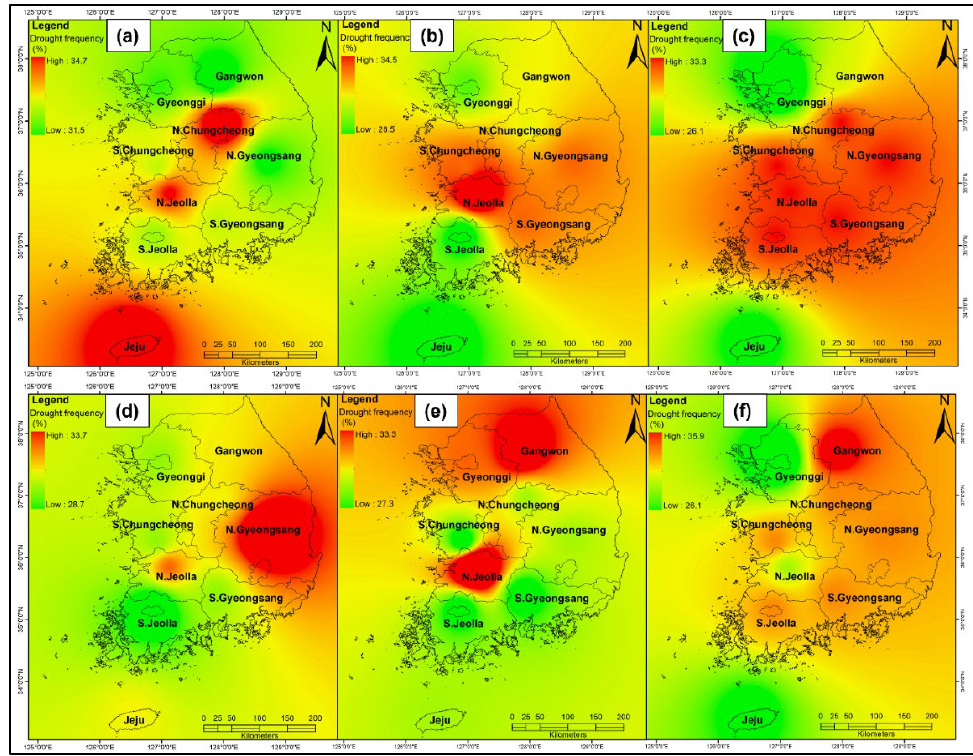
Figure 10. Spatial distribution of drought frequency using SPEI ( a ) 1-month ( b ) 6 month, ( c ) 12-month, and SPI ( d ) 1-month, ( e ) 6-month, and ( f ) 12-month .